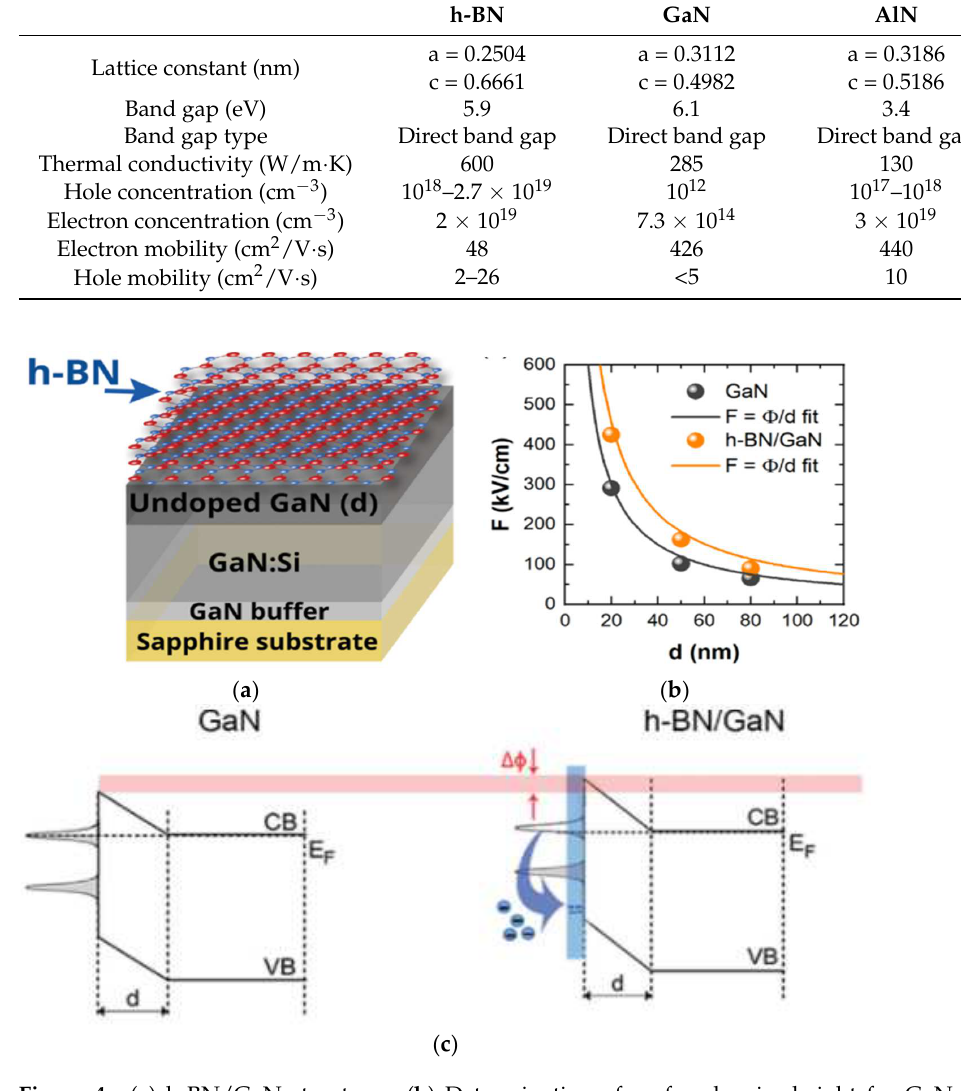
Figure 4. ( a ) h-BN/GaN structure. ( b ) Determination of surface barrier height for GaN and h-BN/GaN structures together with the fitting curves. ( c ) The lowering of Fermi level on the h-BN/GaN interface caused by h-BN [32].